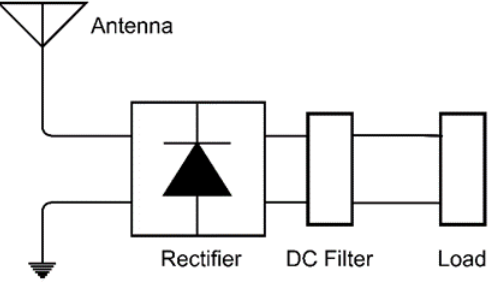
Figure 1. Block diagram of the energy harvesting system based on the rectenna principle.